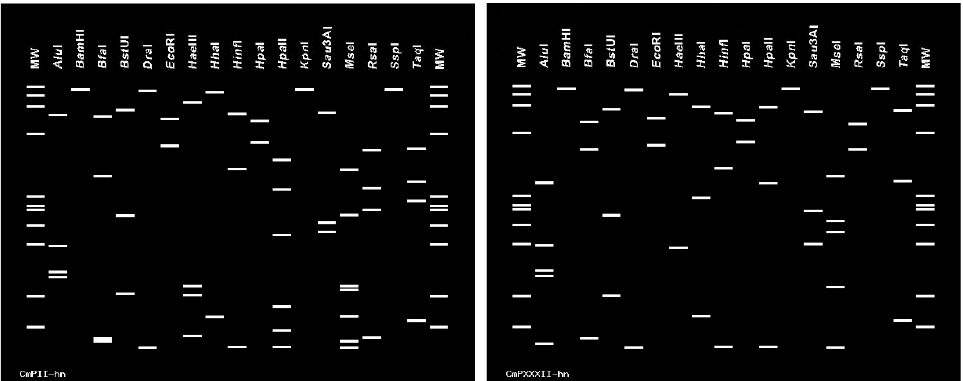
Figure 3. Virtual RFLP profiles of 16S rRNA gene F2nR2 fragments of the Citrus maxima phytoplasma CmPII-hn and CmPXXXII-hn strains. The virtual RFLP patterns of the CmPII-hn and CmPXXXII-hn phytoplasma strains are based on computer-simulated digestions of 17 restriction enzymes, including Alu I, BamH I, Bfa I, Bst UI, Dra I, Eco RI, Hae III, Hha I, Hinf I, Hpa I, Hpa II, Kpn I, Sau 3AI, Mse I, Rsa I, Ssp I and Taq